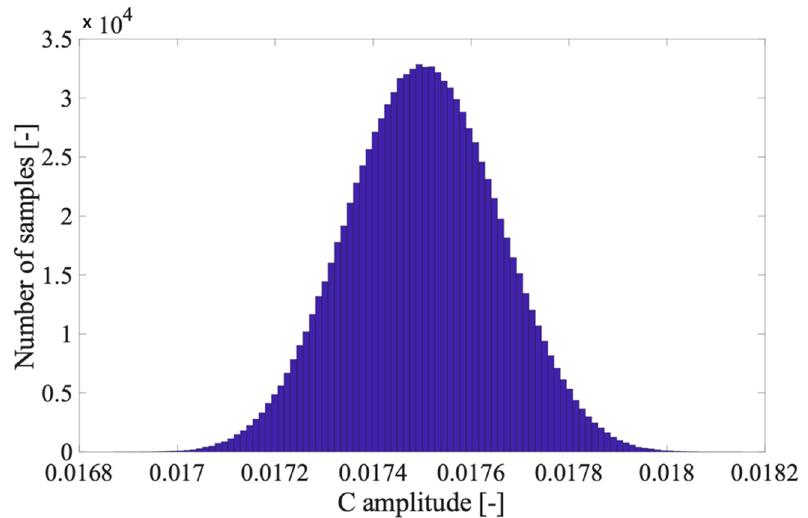
Figure 2. Distribution of 𝐶 when 5 harmonics with consistent amplitudes are considered.